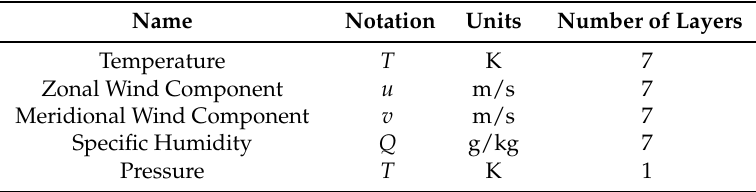
Table 2. Physical variables of the AT-GCM Speedy model.